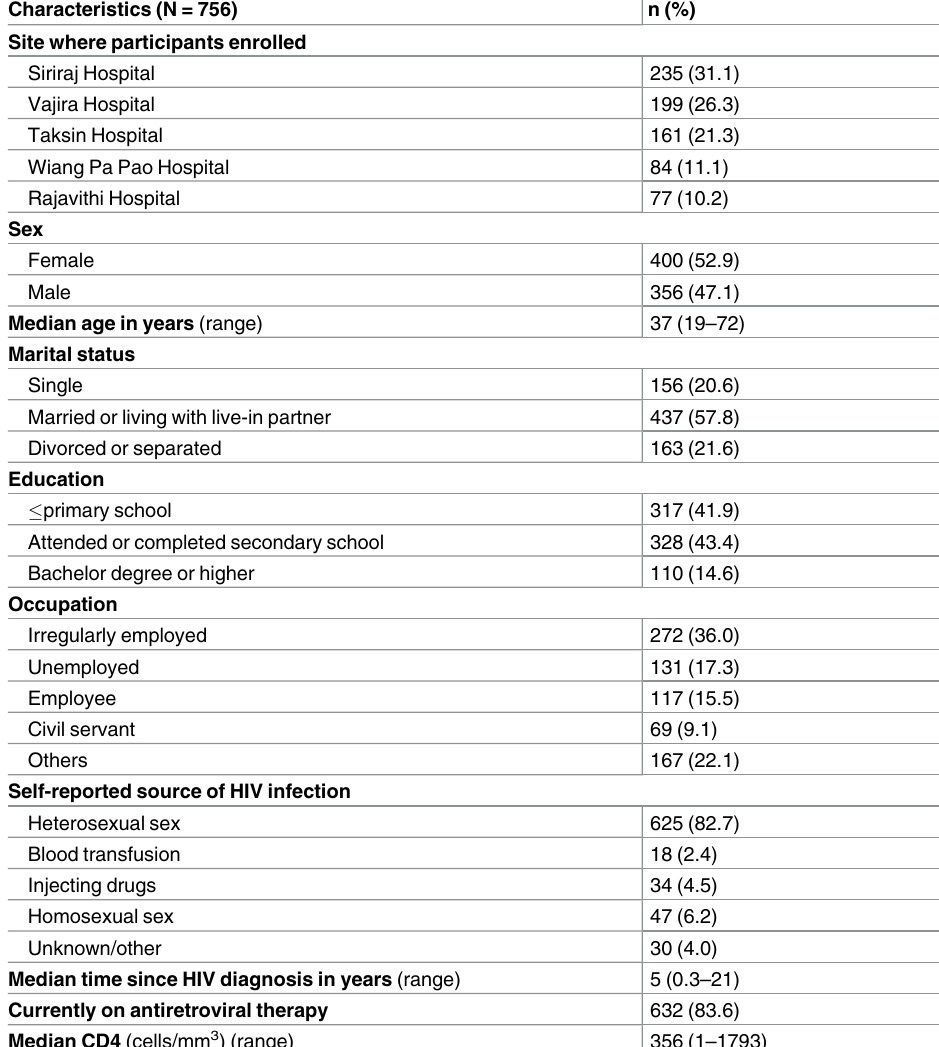
Table 2. Baseline characteristics of people living with HIV enrolled in the prevention with positives intervention assessmentat five hospitals, Thailand, 2008–2009. Characteristics (N = 756) n